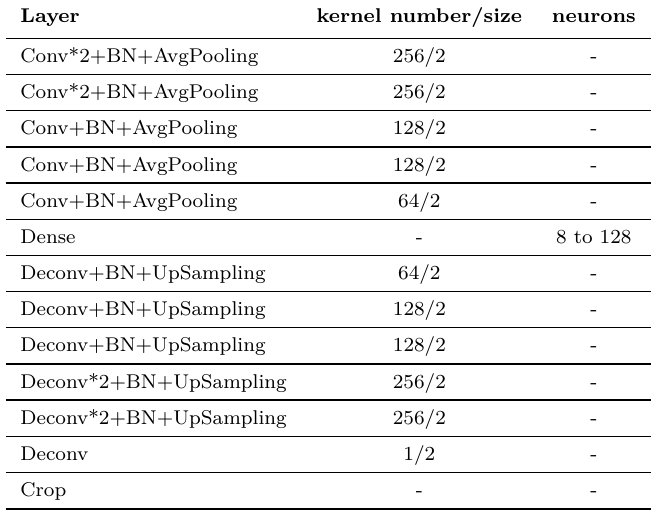
Table 10: Autoencoder architecture used in the